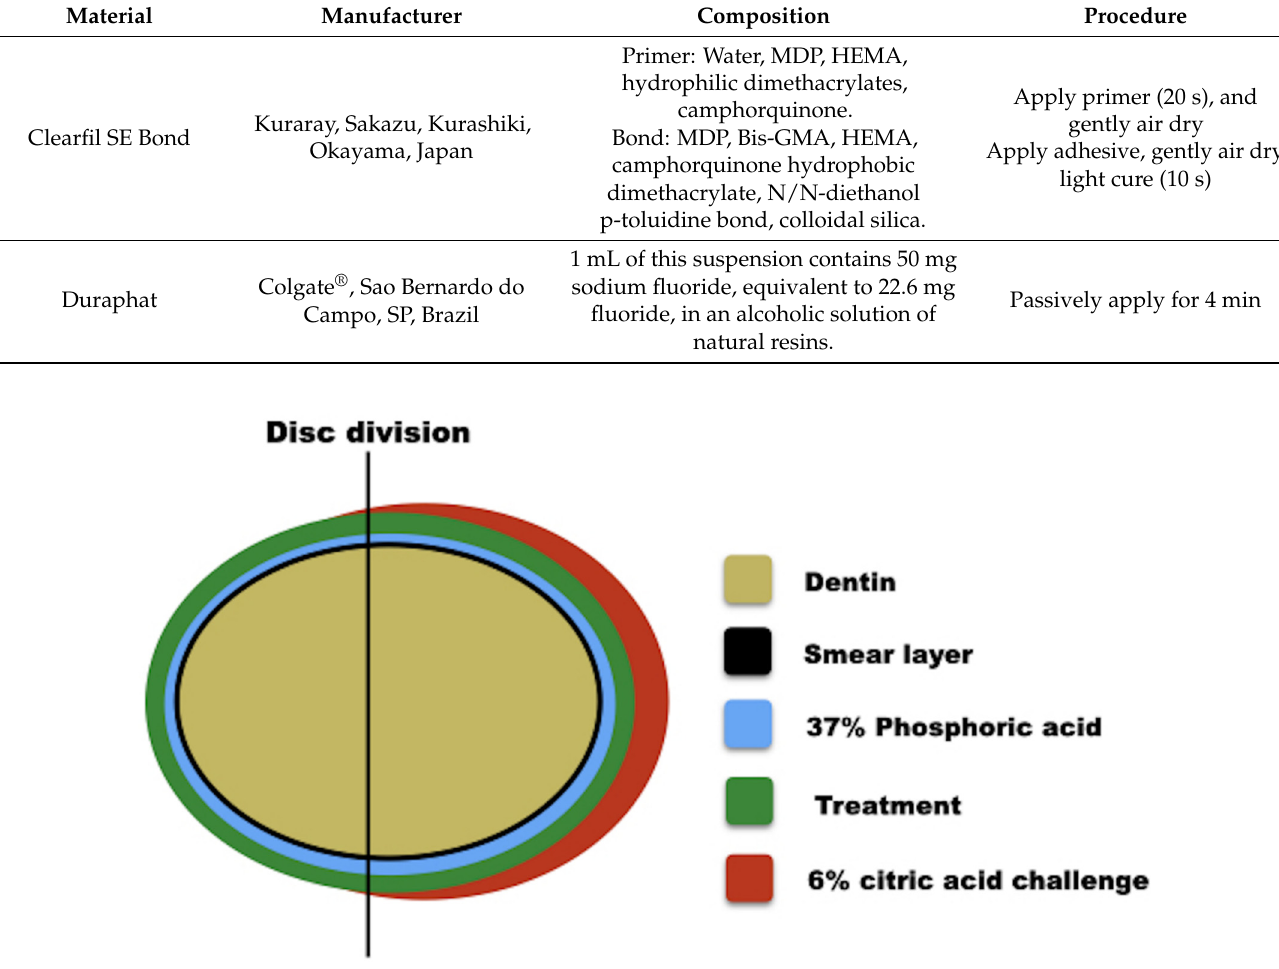
Figure 1. Schematic drawing of the four experimental conditions of the treatment groups.